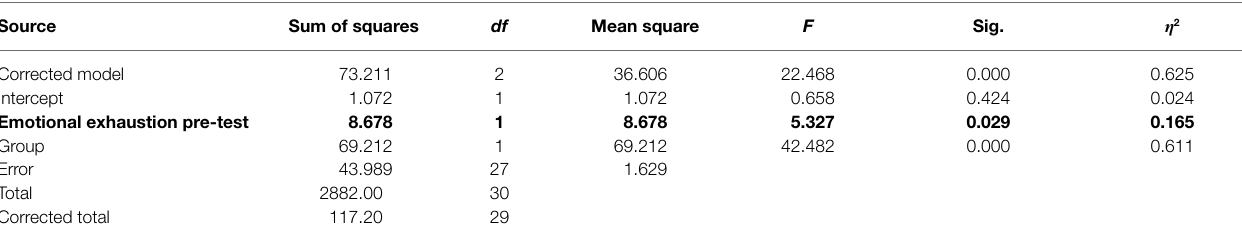
The results of the analysis regarding the effectiveness of the experimental procedure with bold lines are highlighted.